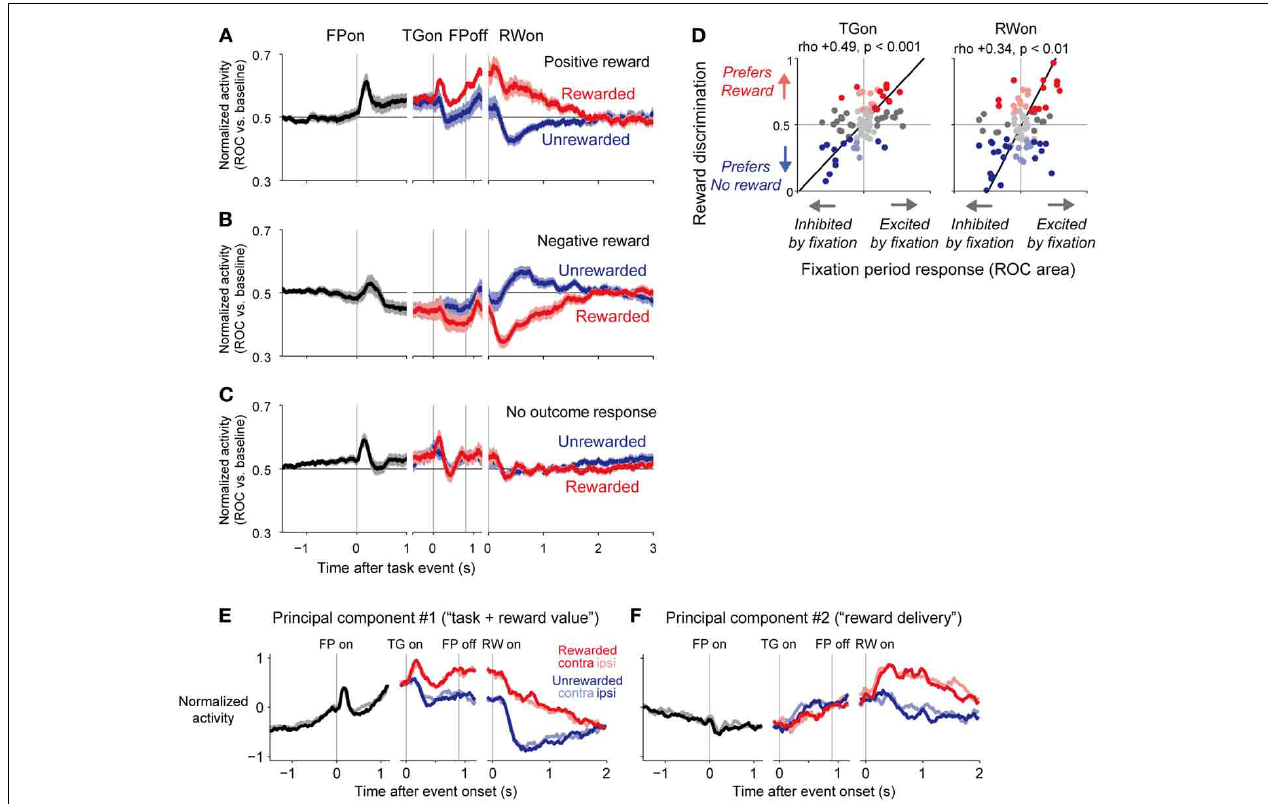
FIGURE 3 | Populationaverage activity of dorsal raphéneuronsseparated by their reward signals in response to the outcome. (A–C) , Normalized activity is shown for the 1DR-MGS task, separately for positive-reward cells (A) , negative-reward cells (B) , and non-outcome responsive cells (C) The neurons were sorted into these categories based on significant reward discrimination during a 150–450-ms window after outcome onset (gray bar on the x-axis; p < 0 . 05, Wilcoxon rank-sum test). Thick lines, mean normalized activity; light shaded areas, 1 SEM. (D) Neural activity during the fixation period was positively correlated with reward coding during the target and outcome periods. The x-axis indicates the fixation period response, which was measured as the ROC area for each neuron for discriminating between its firing rate at 500–900ms after fixation point onset vs. the pre-fixation period at 0–400ms before fixation point onset. The y-axis indicates reward discrimination, which was the difference in reward responses between the large- and small-reward trials. The text indicates rank correlation (rho) and its